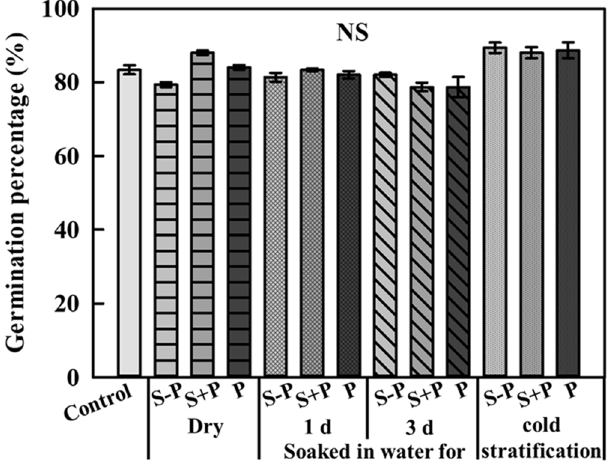
Figure 2. Germination percentage of lettuce seeds treated with extracts from dry seeds, soaked in water for one and three days, and subjected to cold stratification. The treatments were further divided into seeds without pericarps (S − P), seeds with pericarps (S + P), and pericarps only (P) after seven days ( n = 3). NS means no significant